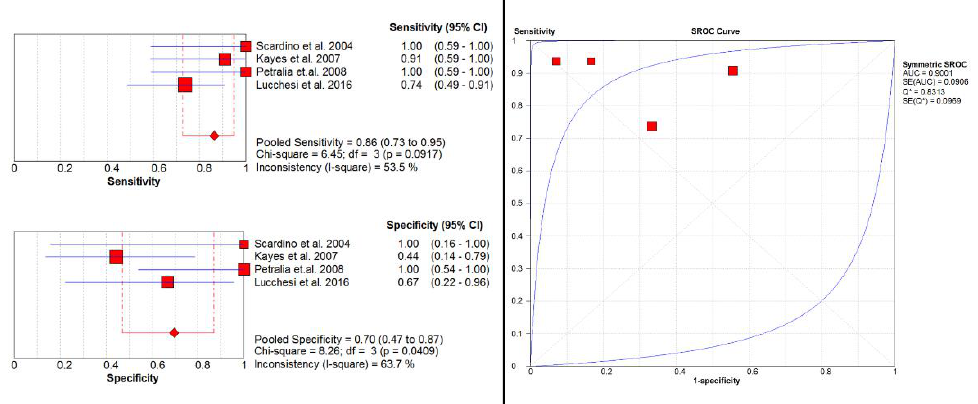
Figure 4. P ooled sensitivity, specificity, and SROC curve of MRI in pathologic T- stage ≥ 2. Figure 4. Pooled sensitivity, specificity, and SROC curve of MRI in pathologic T-stage ≥